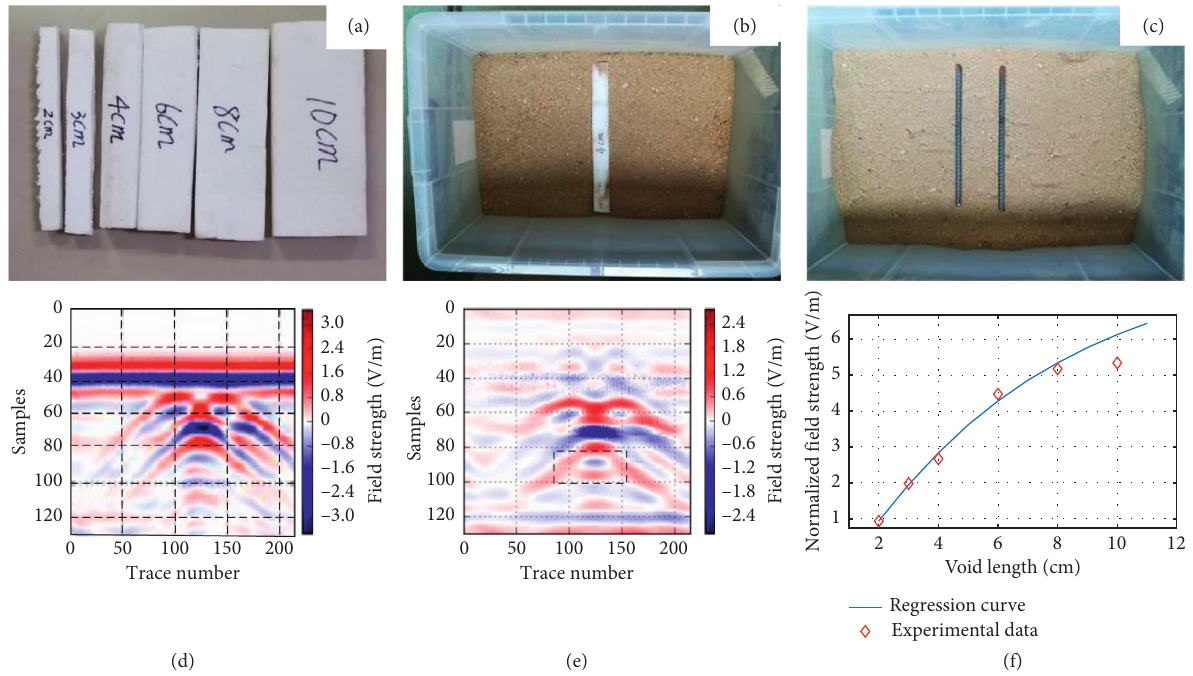
Figure 14: Experiment and processing result: (a) experimental void defects; (b) void defect in lower layer; (c) rebar in upper layer; (d) test result when void length l v � 6cm; (e) filtered result of (d); (f) comparison between regression curve and experimental data. Table 4: Void-size determination errors in